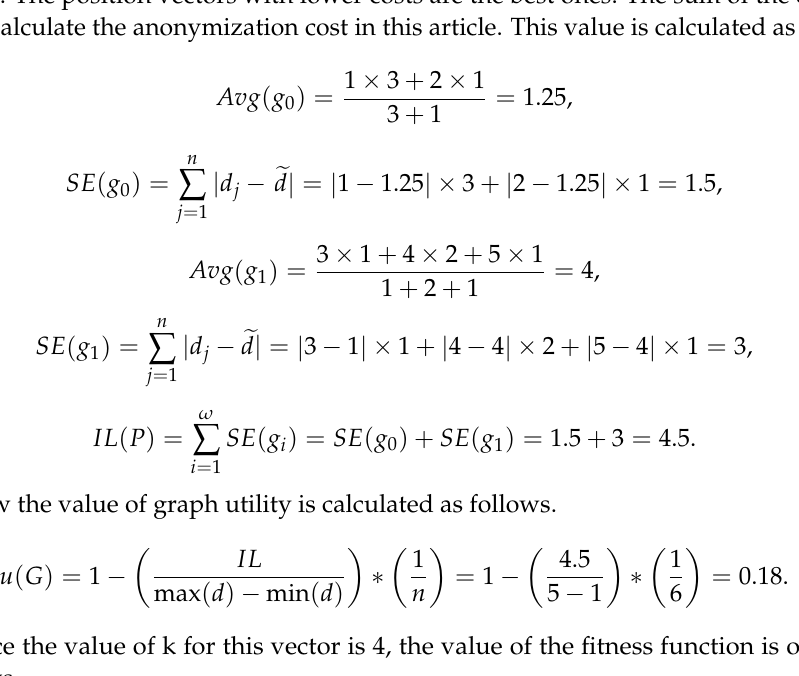
Figure 5. Normalized position vector .